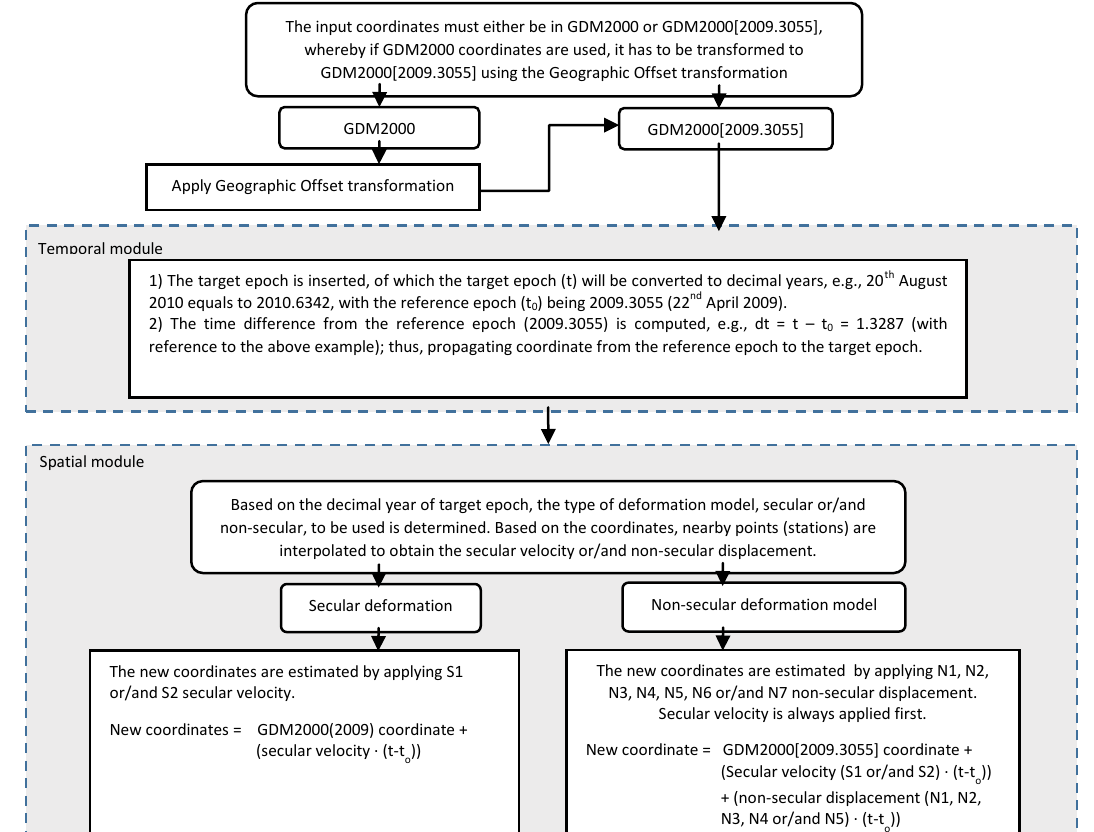
Figure 7. The proposed process framework for the DBMS of the semi-dynamic datum for